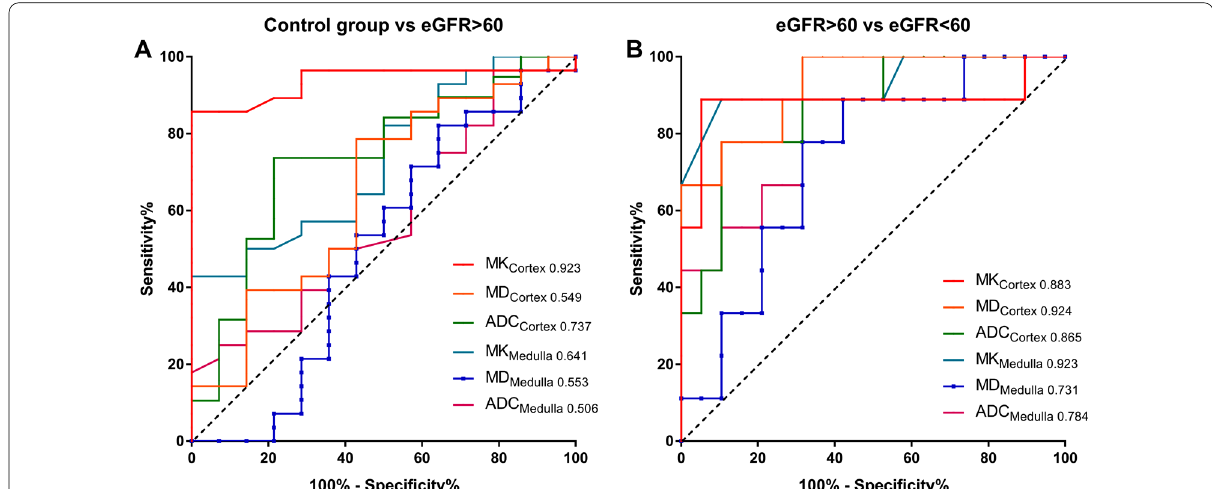
Fig. 8 The ROC curve analysis of cortical and medullary diffusion parameters to distinguish between IgAN patients with eGFR > 60 mL/min/1.73 m 2 and control group, or IgAN patients with eGFR < 60 mL/min/1.73 m